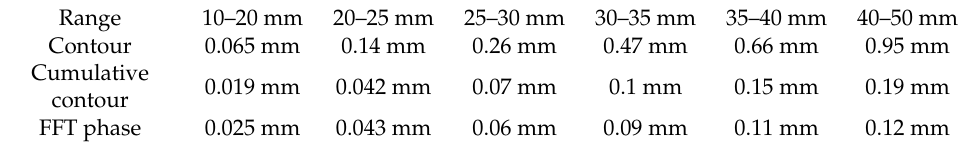
Table 1. Comparison of the accuracy of bending demodulation